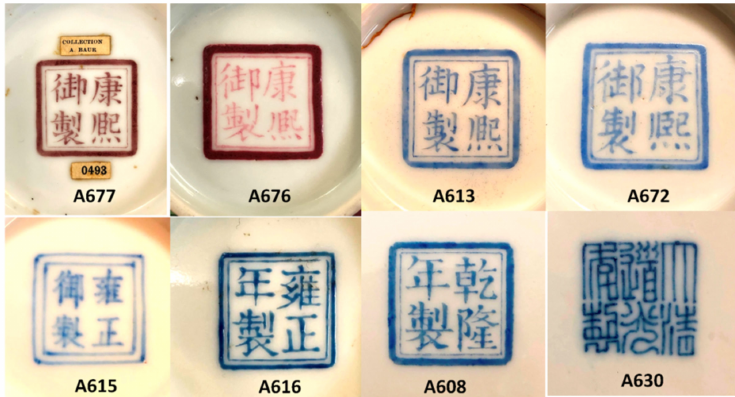
Figure 2. Views of the imperial bowl marks. See Table 1 for